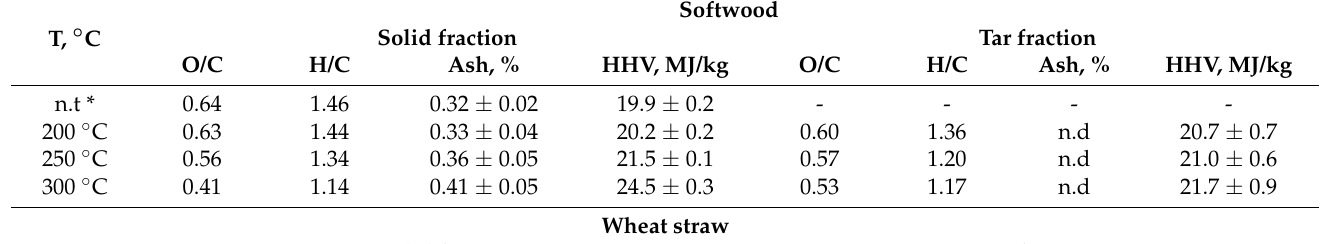
Table 2. Comparison of the properties of solid and tar fractions that were obtained by MW-assisted torrefaction of softwood, wheat straw, and peat, performed at different temperatures in terms of O/C and H/C atomic ratios, HHV, and ash content in them.